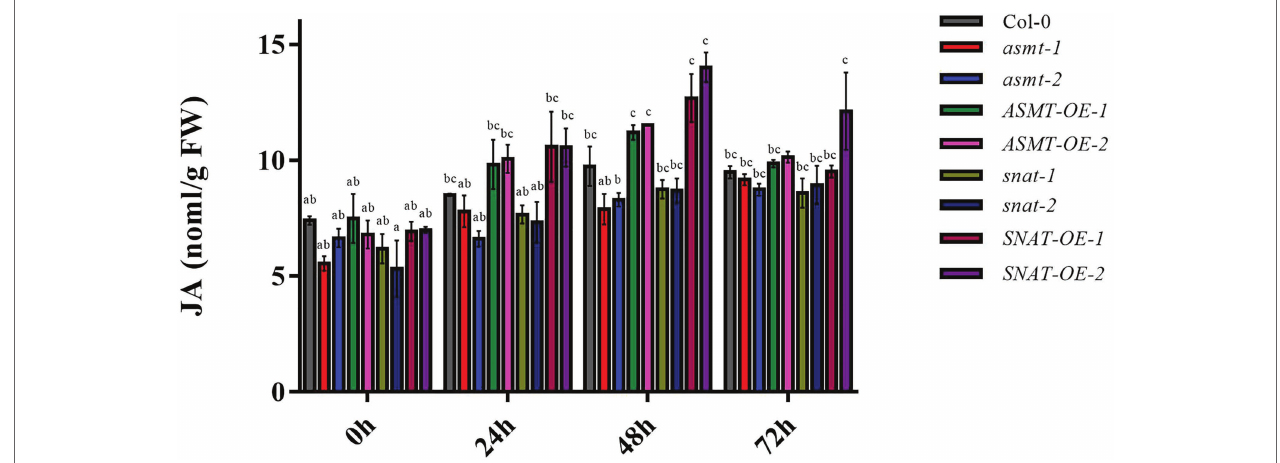
FIGURE 5 | Jasmonic acid (JA) content following B. cinerea treatment. The content of JA in 4-week-old wild-type (Col-0), ASMT -overexpressed ( ASMT-OE-1 , ASMT-OE-2 ) plants, SNAT -overexpressed ( SNAT-OE-1 , SNAT-OE-2 ) plants, snat silencing lines ( snat-1 , snat-2 ), and asmt silencing lines ( asmt-1 , asmt-2 ) plants at different time points (0, 24, 48, and 72 h) after inoculation with B. cinerea . The data (mean ± SD) were calculated using three replicate assays, with the SEs indicated by the vertical bars. Different lowercase letters indicate statistically significant differences ( p < 0.05). FW, fresh